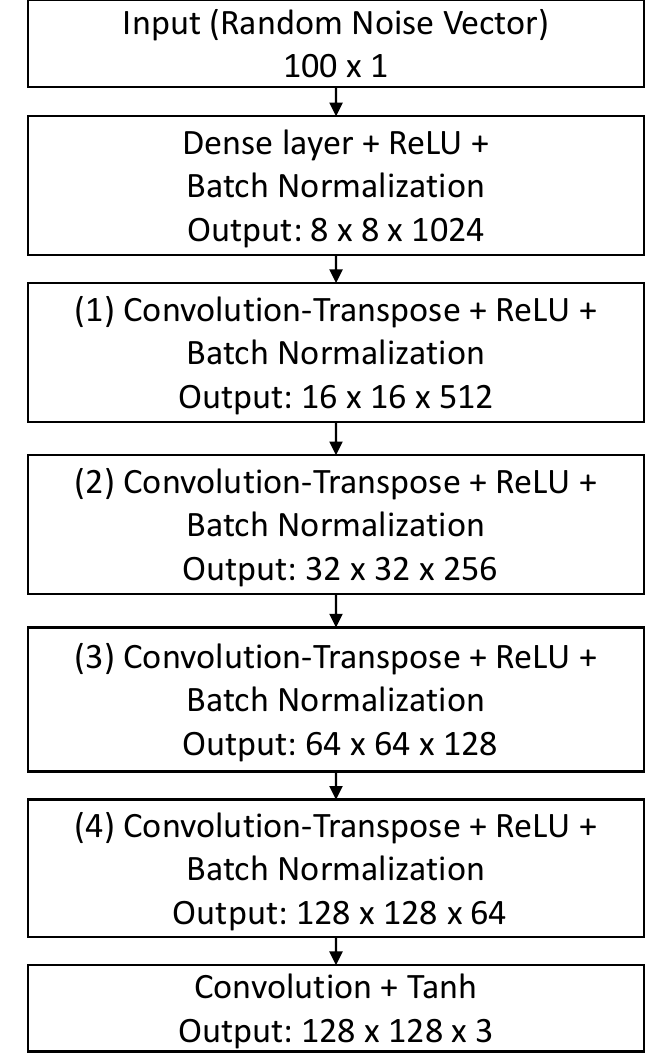
Figure 3. Generator Network